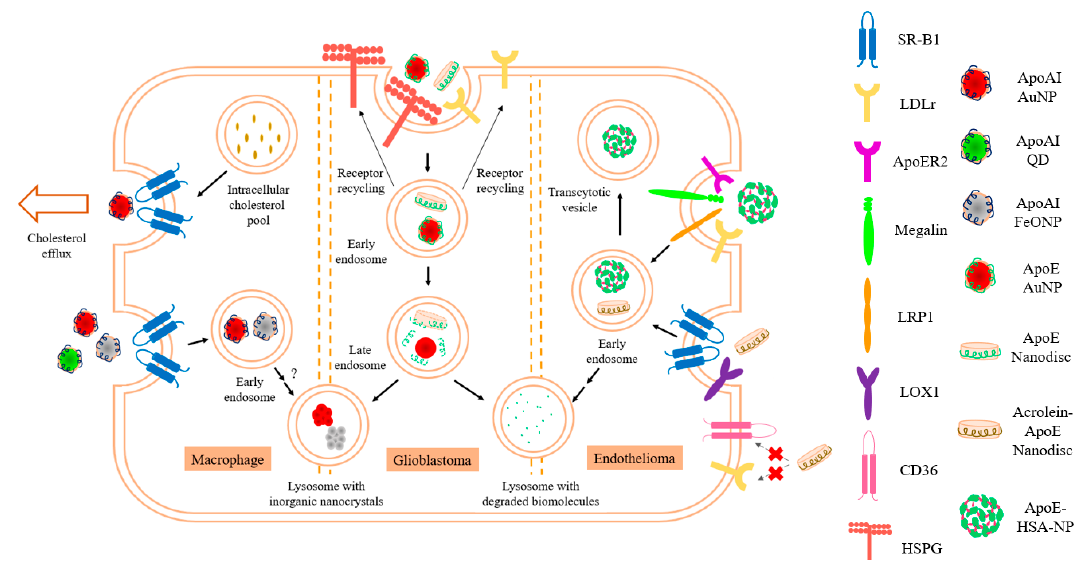
Figure 3. Entry mechanism(s) for various types of nanoparticles (NPs) in cells. HDL reconstituted with apoAI and various types of inorganic nanocrystals are taken up by macrophages, a process that is mediated by SR-B1. HDL-AuNP have been shown to promote cholesterol e ffl ux not only in THP-1 macrophages, but also in other cells that express SR-B1 such as B lymphoma cells and myeloid derived suppressor cells (MDSCs). HDL reconstituted with apoE3, either as discoidal or spherical NPs, could gain entry through the LDLr family of proteins in GBM and possibly also through heparan sulfate proteoglycans (HSPG). In endothelial cells, rHDL reconstituted with acrolein-modified apoE showed entry through both SR-B1 and LOX1, but not through conventional oxidized LDL receptors such as CD36. Interestingly, HSA-crosslinked-apoE3 NP without lipid content were shown to enter brain endothelial cells mainly through LRP-1, although other LDLr family receptors could also contribute to the entry.